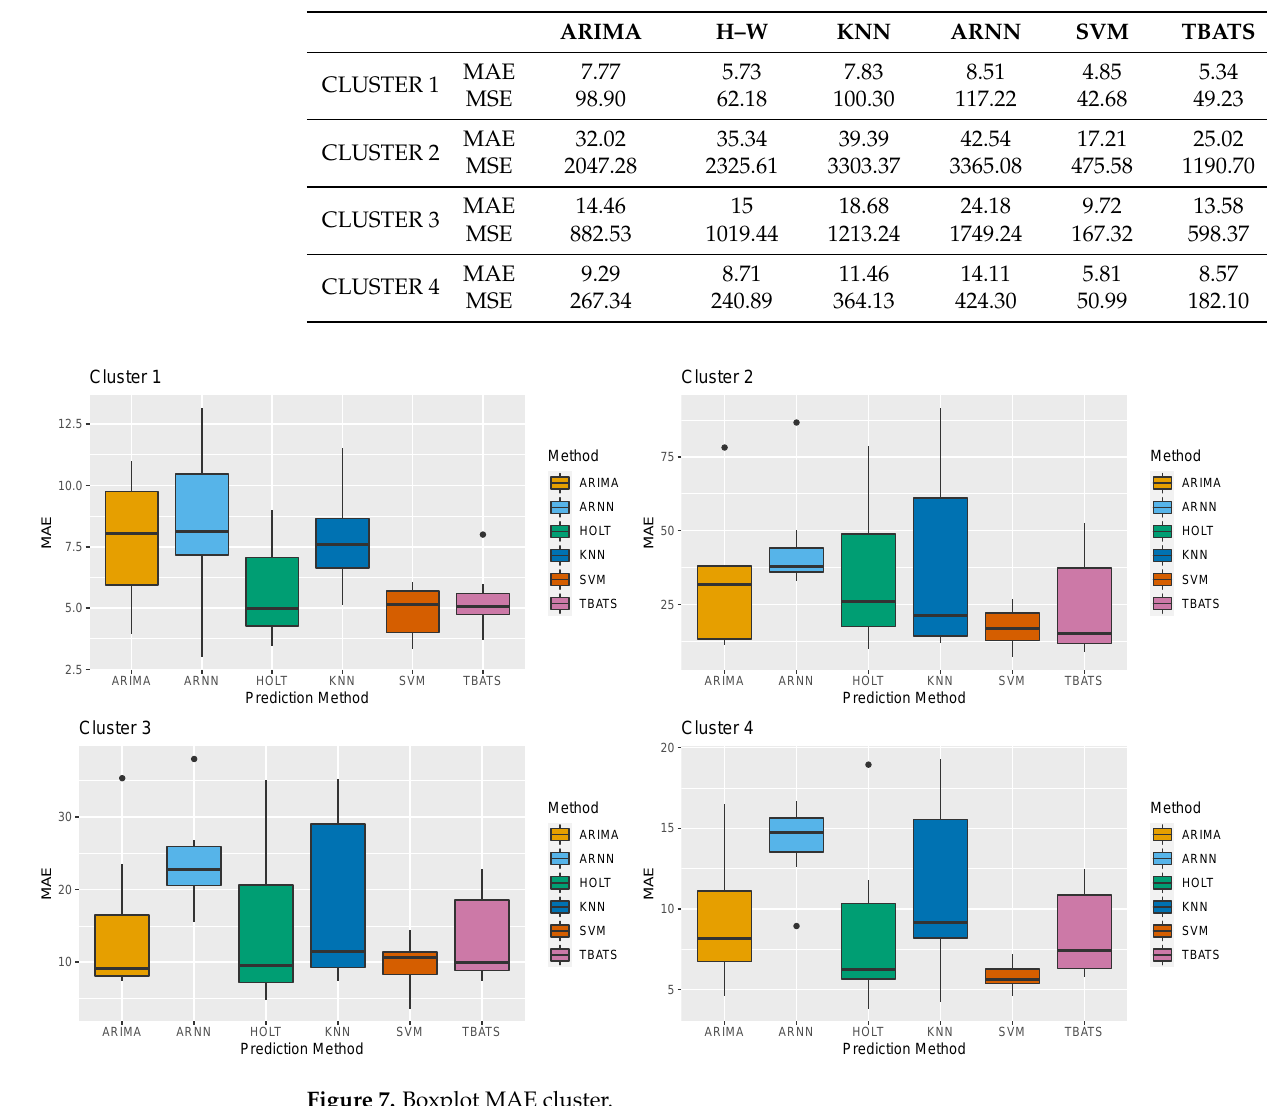
Table 1. Overall MAE and MSE for each model in each cluster.